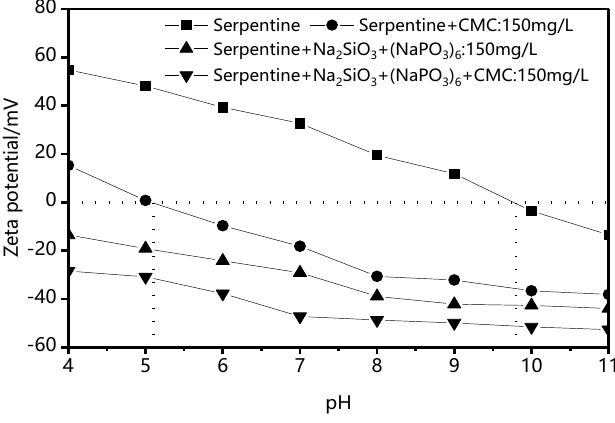
Figure 8. Zeta potential of serpentine at different pH.